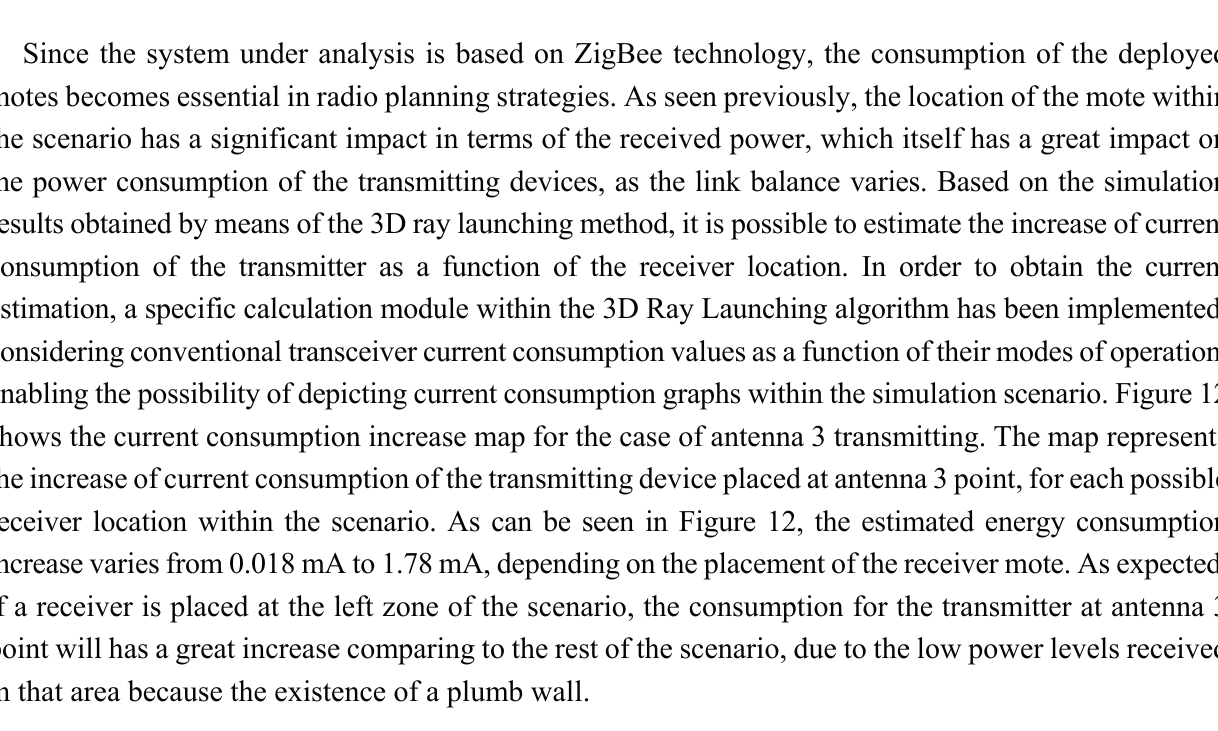
Figure 11. Delay spread when antenna 3 is transmitting for the plane at 1 m